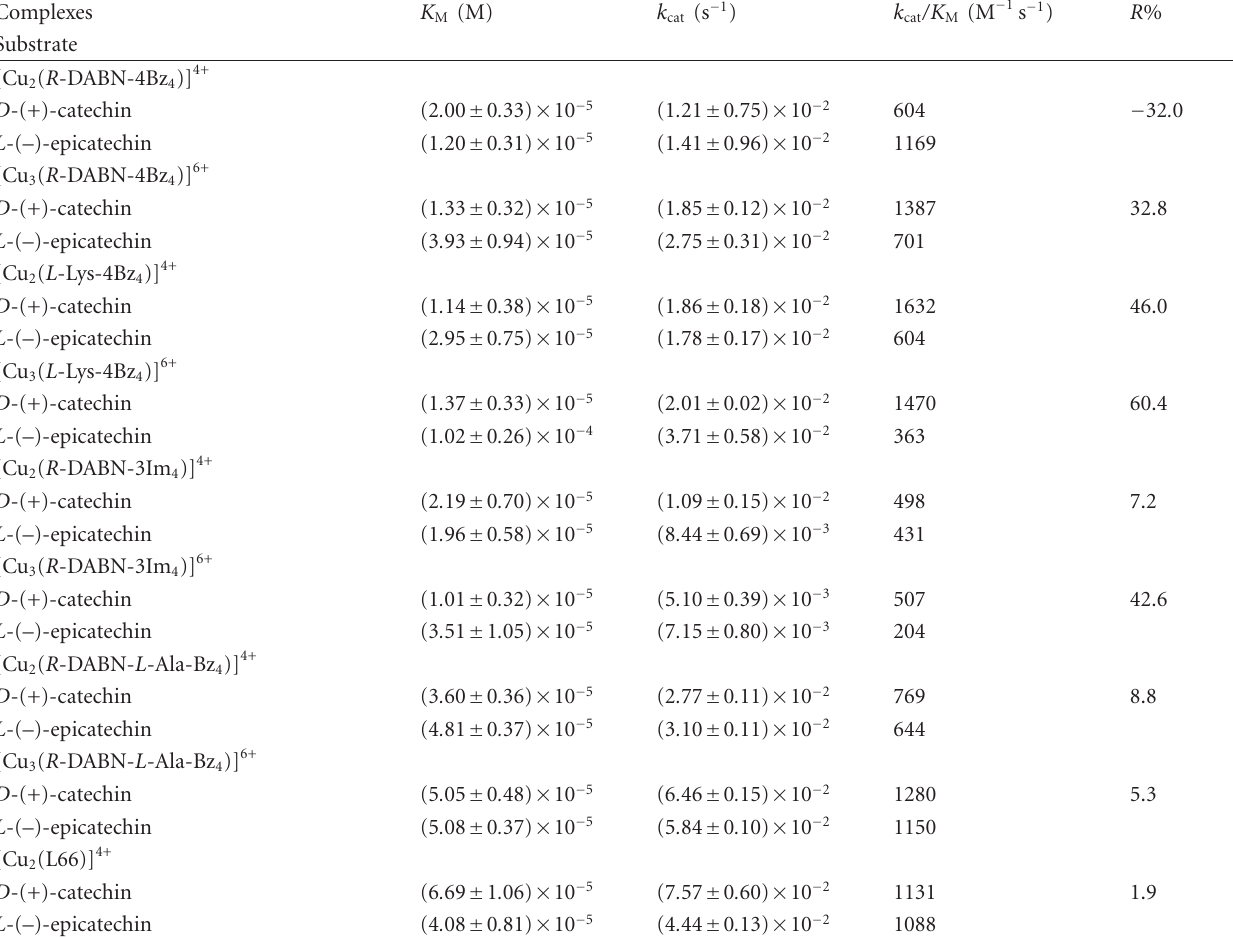
Table 1: Kinetic parameters for the stereoselective oxidations of D -(+)-catechin and L -(–)-epicatechin in methanol-aqueous phosphate bu ff er, pH 7.0 at 20 ± 0 . 1 ◦